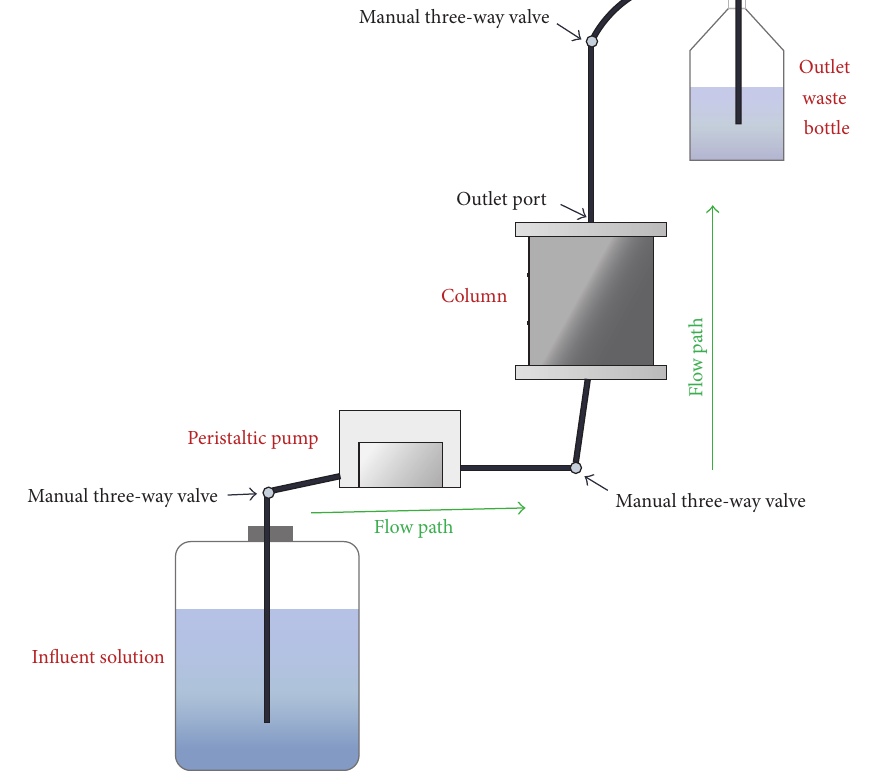
Figure 1: Schematic of the column